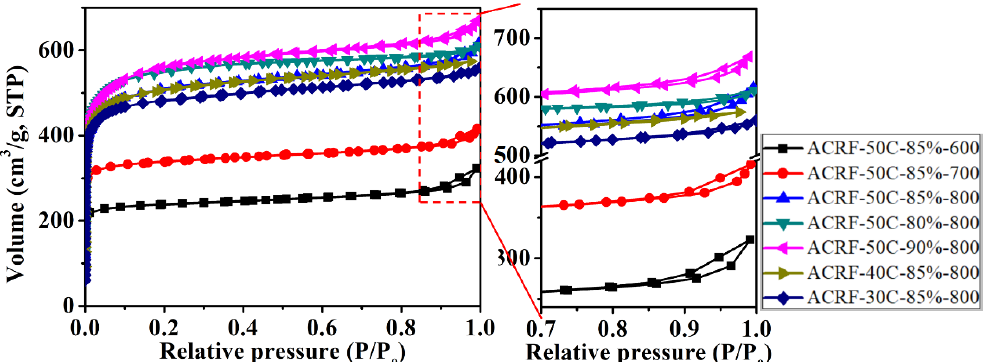
Figure 4. N 2 adsorption-desorption isotherms of ACRFs at 77 K.